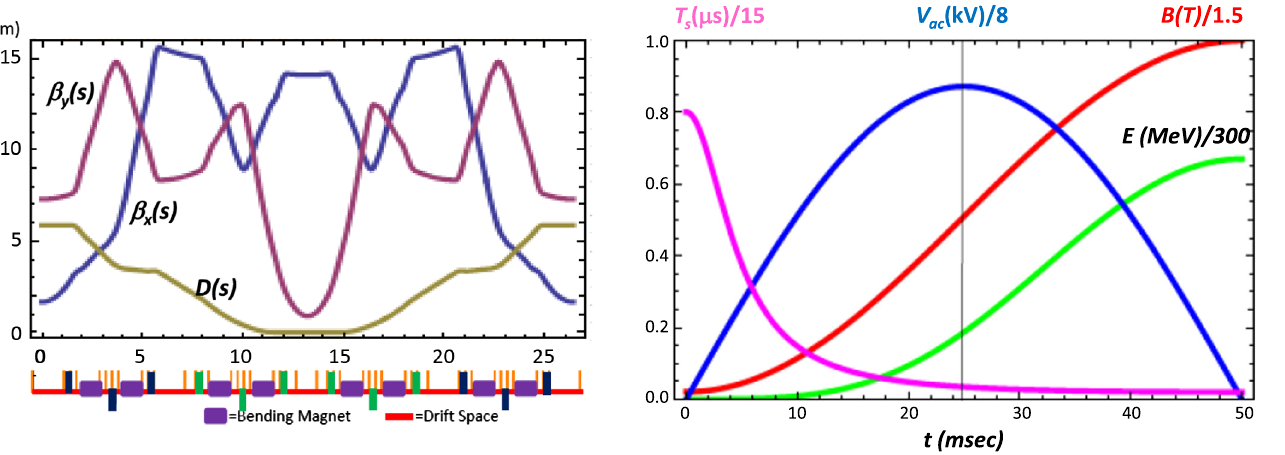
FIG. 7. Lattice functions and lattice for the single super- periodicity.